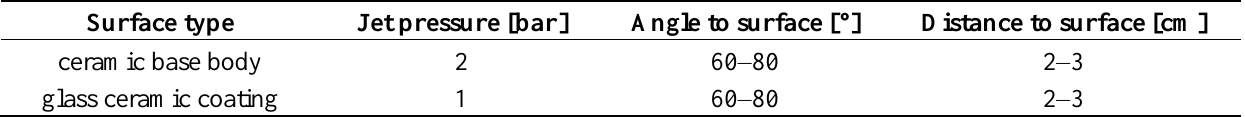
O , grit size: 110 2 3